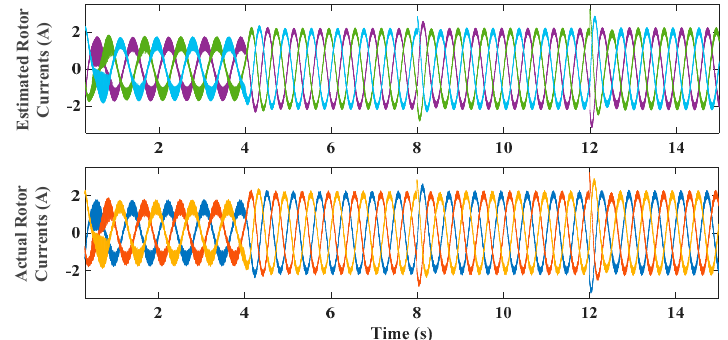
Figure 2. Verified estimated response of the IM rotor currents compared with the corresponding actual values.